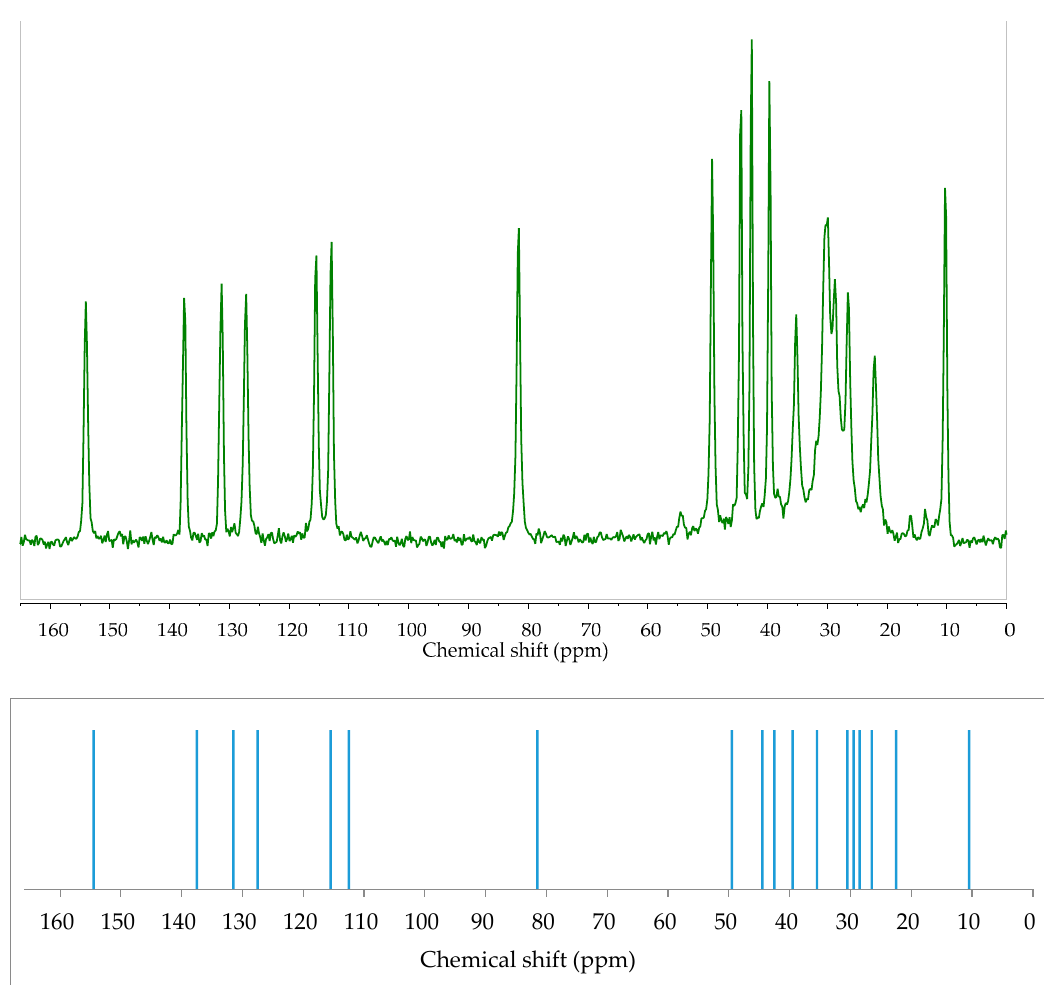
Figure 1. Experimental (top, green) Cross Polarization Magic Angle Spinning (CP MAS) and calculated (bottom, blue) GIPAW 13 C solid-state NMR spectra of E2. Very good agreement between calculated and experimental values proves the usefulness of DFT calculations in solid-state analysis of